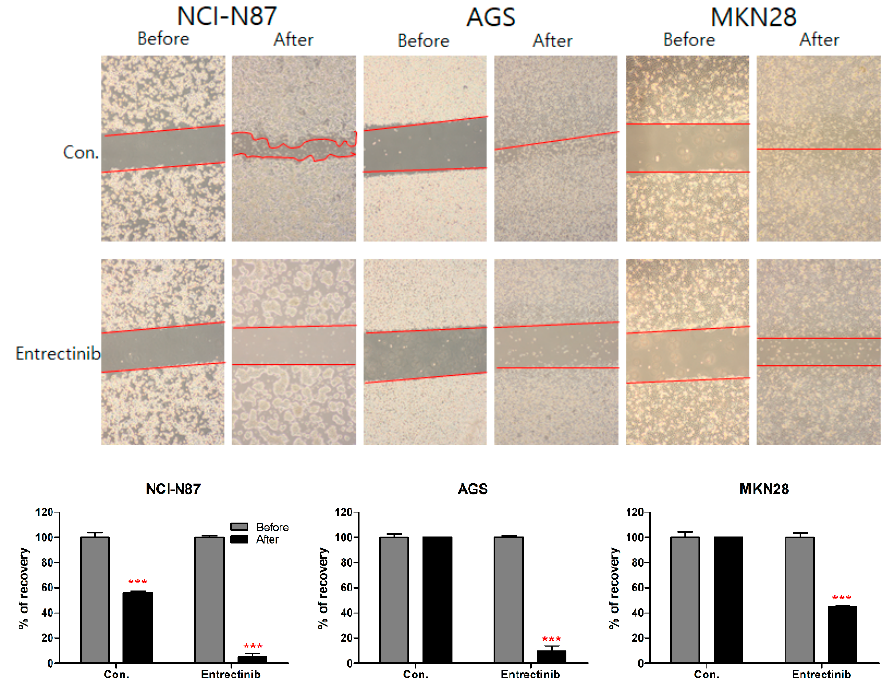
Figure 7. Effects of entrectinib on migration in gastric cancer cell lines. A wound-healing assay was used to assess the effect of entrectinib on the migration abilities of NCI-N87, AGS, and MKN28 cells. Entrectinib-treated gastric cancer cells showed suppressed migration ability. Con, non-treated control cells. *** p < 0.001 compared with before group.